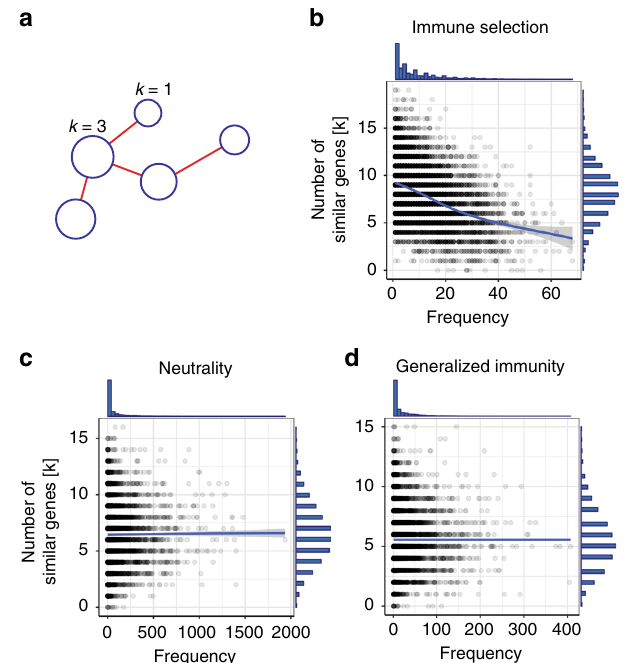
Fig. 4 The relationship between gene frequencies and number of genes similar to a focal gene is different between selection and null models. a In a gene similarity network, each node represents a unique gene circulating in the population and the edges encode the sharing of at least one allele between genes. The size of the node is proportional to its frequency in the population and the node degree k depicts the number of genes that share at least one allele with the focal gene. There is a negative correlation between a gene ’ s frequency and degree in the immune selection scenario ( b , r = − 0.412, t -test: p -value < 2.2e – 16), but not in the complete neutrality ( c , r = 0.016, t -test: p -value = 0.17) or generalized